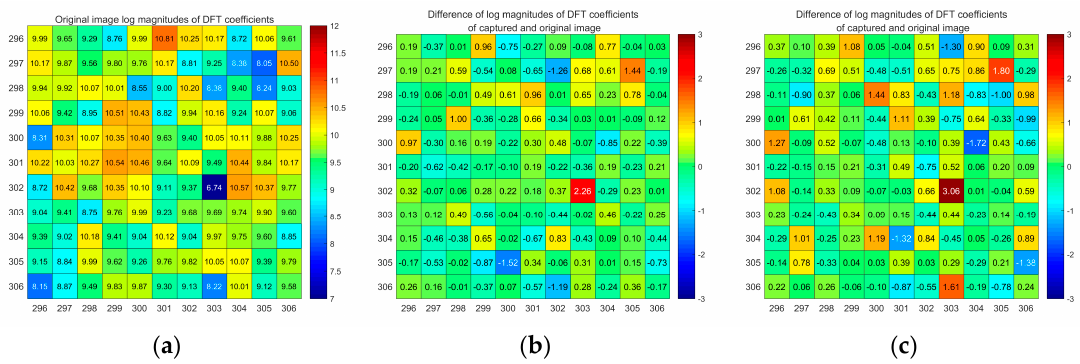
Figure 6. Detailed variations of discrete Fourier transform (DFT) coefficient magnitudes during screen-cam process. ( a ): Original image spectrum in the log domain. ( b ) and ( c ): Difference in log DFT magnitudes of original image and captured image at a vertical distance of 30 and 50 cm.